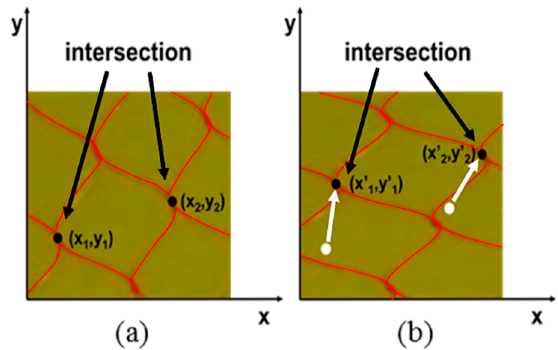
Figure 2. Coordinates of net intersections. ( a ) Reference image; ( b ) Deformed image.